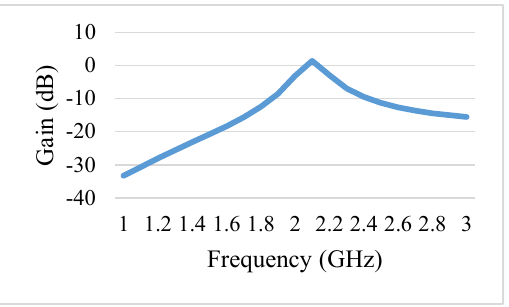
Fig 1.10 Gain vs Frequency Relationship of Antenna 2